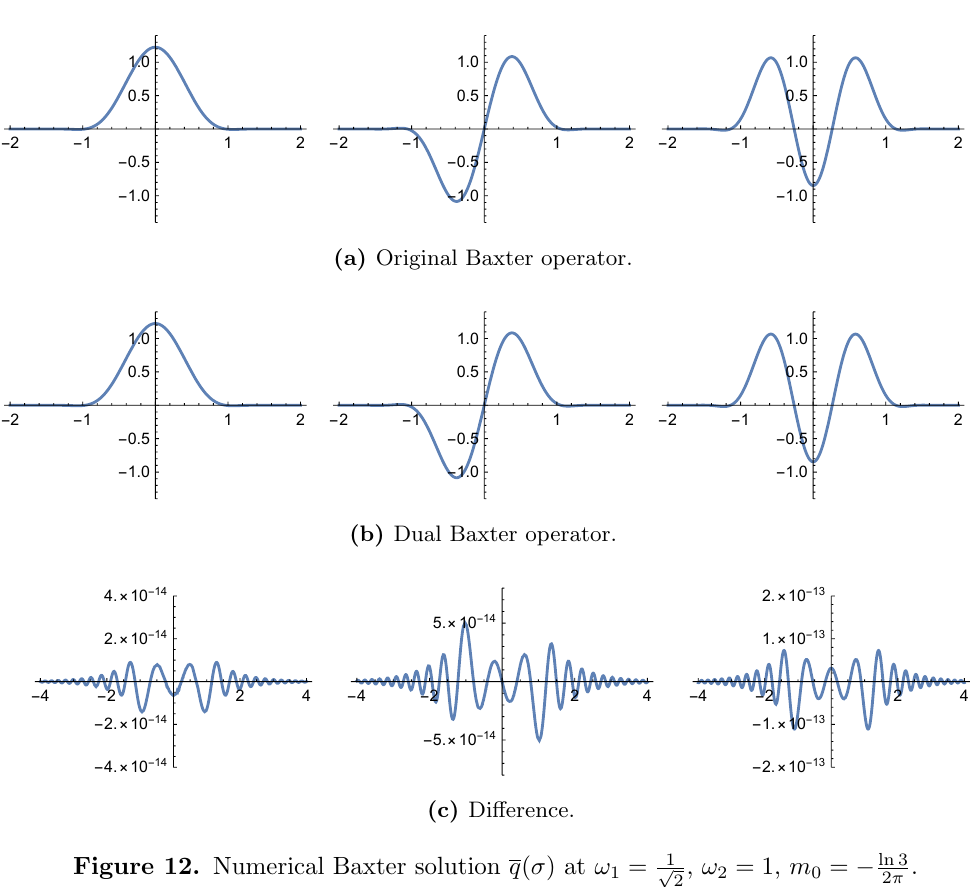
, ! 2 = 1, m 0 = (cid:0) ln3 2